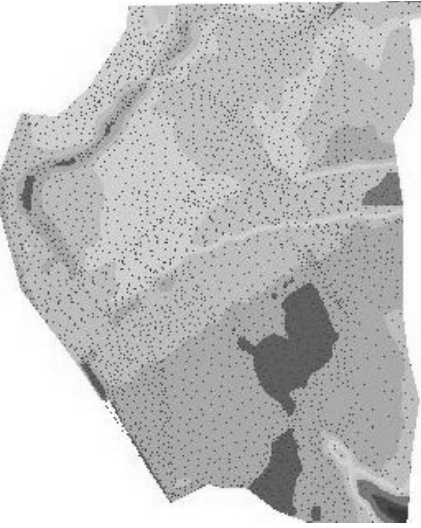
Fig 5. Distribution of segment Vilnius city DTM control points